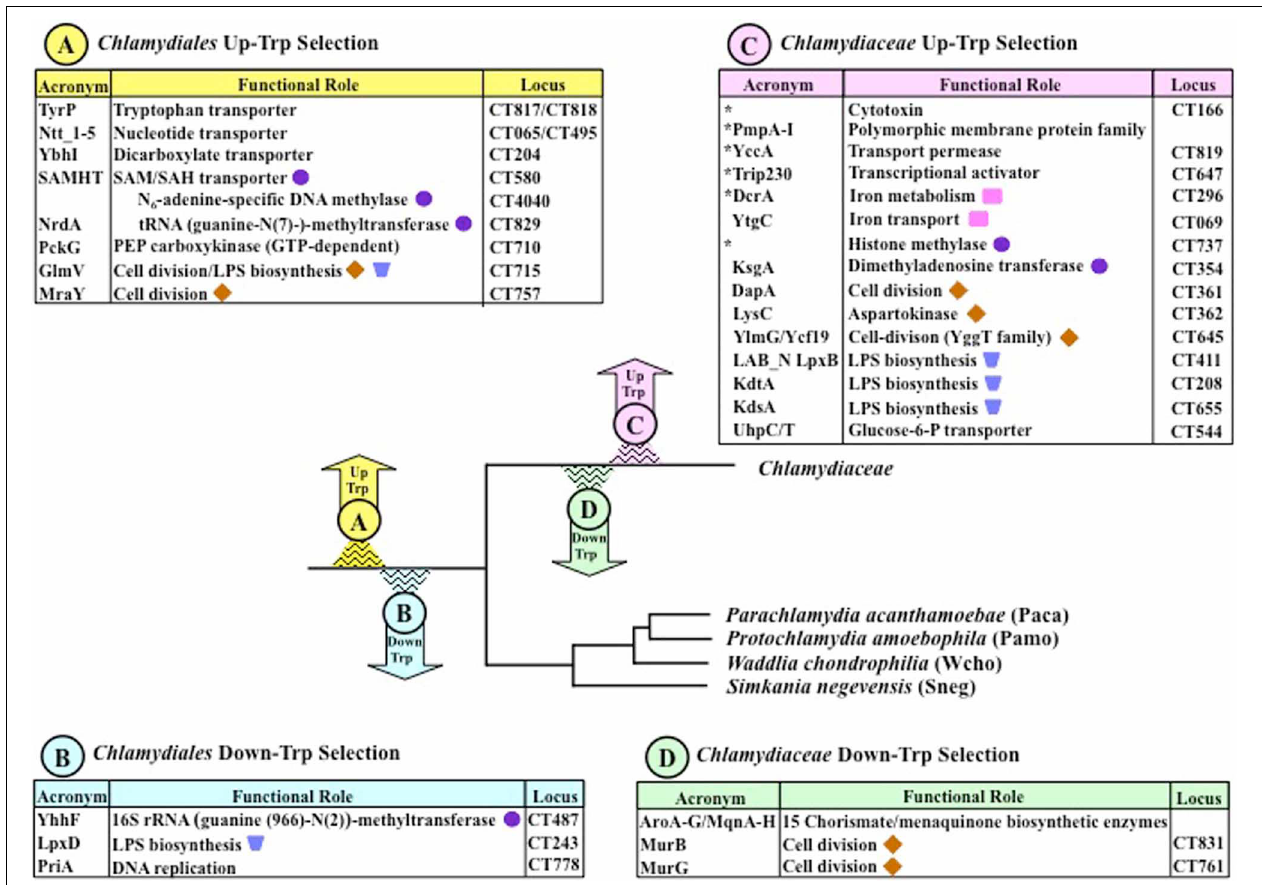
FIGURE 4 | Events of Up-Trp and Down-Trp selection in phylogenetic context. Early evolutionary events, i.e., ancestral to the Chlamydiales Order, are show in yellow (Up-Trp) and blue (Down-Trp). Later events specifically ancestral to the Chlamydiaceae are shown in pink and green. Even more recent events distinguish C. trachomatis from C . muridarum as previously